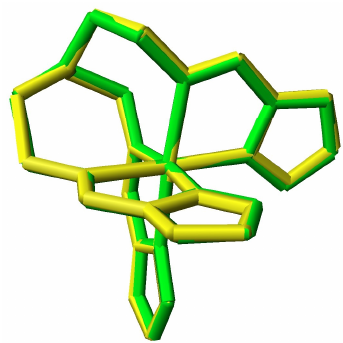
Figure 5. Superimposed structures of LS (green, 30 K) and HS (yellow, 293 K) Mntren(Pyr) 3